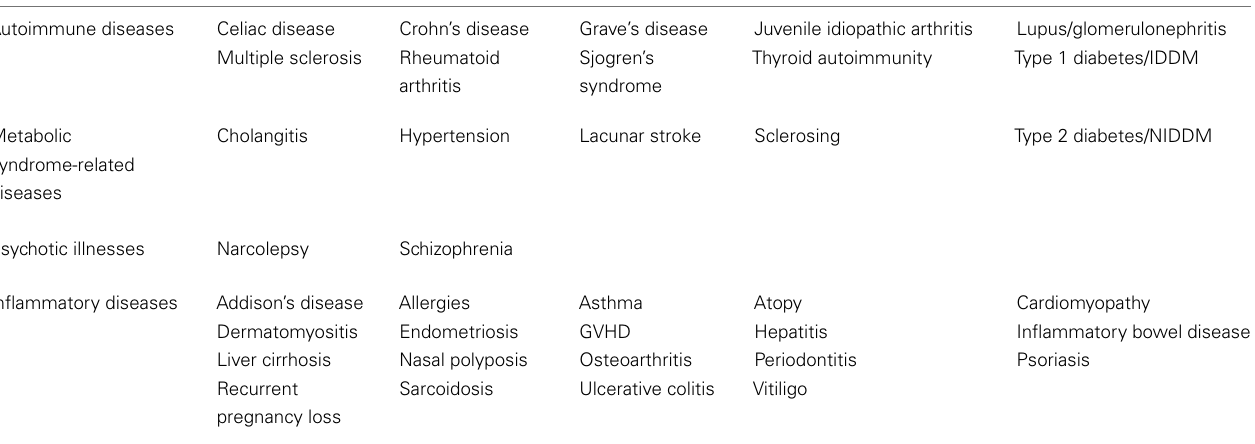
Table 1 | The MHC class II genes are associated with various diseases and disorders. Autoimmune